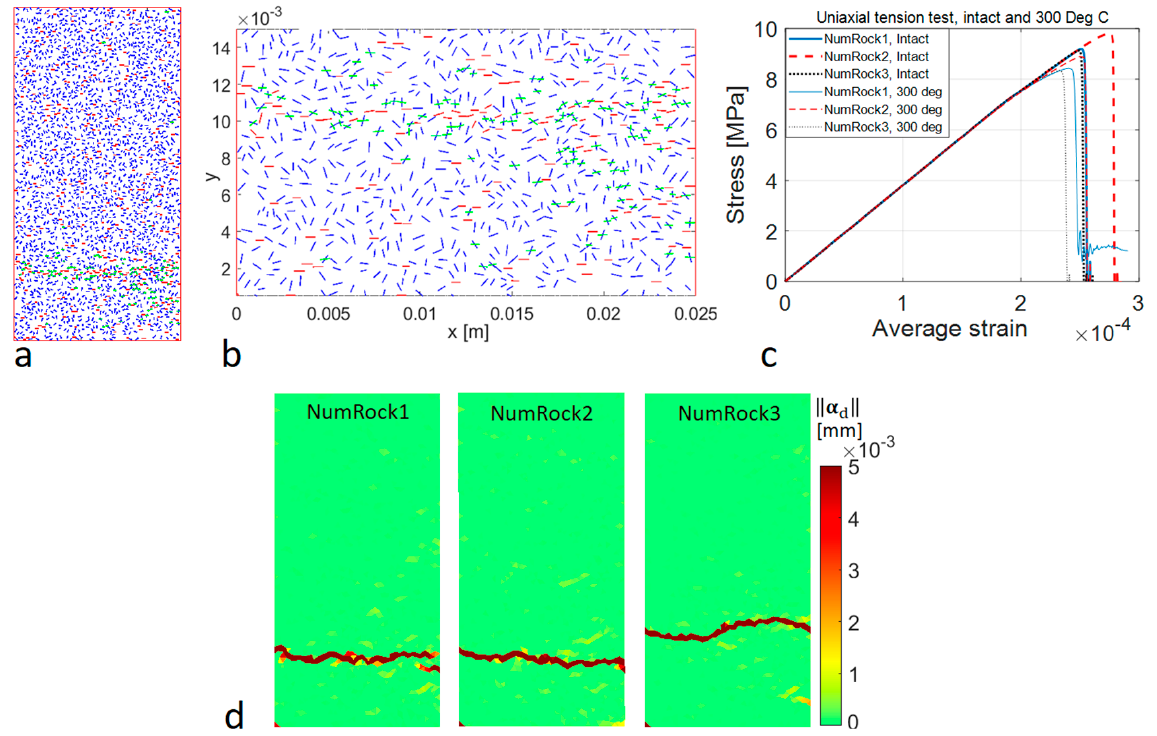
Figure 7. Simulation results for uniaxial tension test (heat treated rock, 300 ° C): ( a ) cracks with NumRock1; ( b ) close up detail (blue = thermal cracks, red = tensile cracks, green = new cracks in elements with a thermal crack); ( c ) average stress–strain curves; ( d ) failure models represented by crack opening magnitudes.